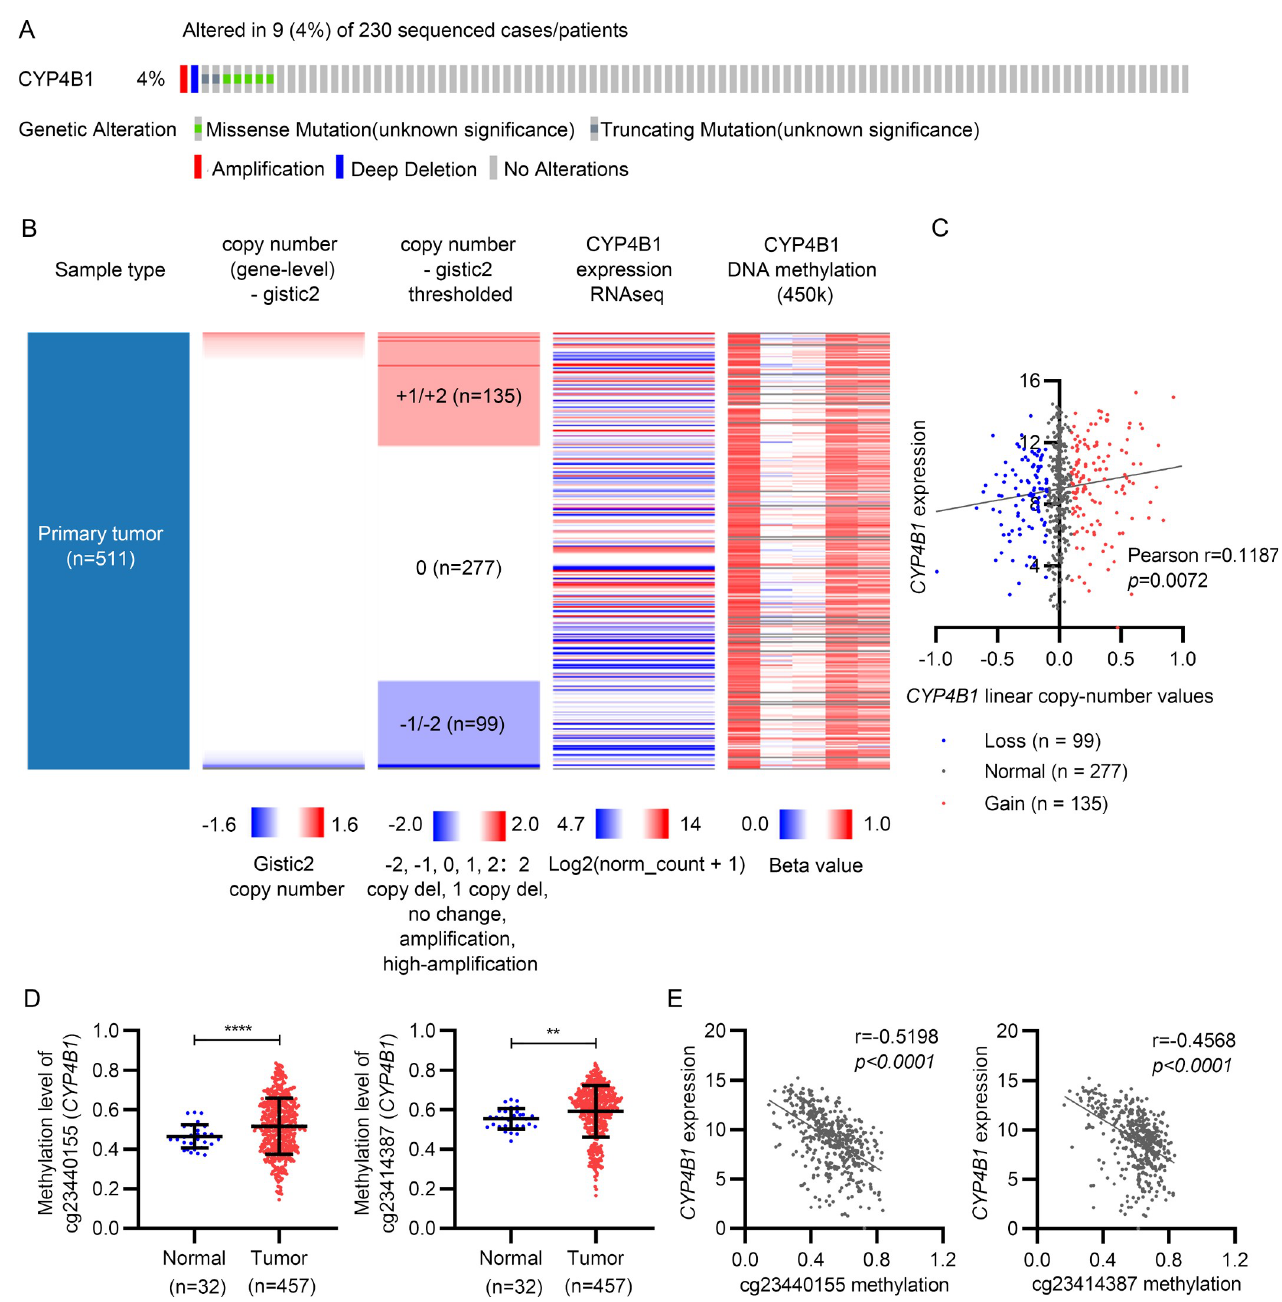
Fig 4. CYP4B1 expression was modulated by its gene alterations and DNA methylation in LUAD. (A) Genetic alterations of CYP4B1 in LUAD. (B) Heatmap of CYP4B1 expression, DNA copy number alterations (gistic2 linear and gistic2 thresholded), and DNA methylation (Methylation 450k). (C) CYP4B1 expression correlates with its linear copy number values by linear regression analysis. (D) DNA methylation level of cg23440155 and cg23414387 sites is significantly upregulated in LUAD tissues when compared with adjacent normal tissues. (E) CYP4B1 expression correlates with cg23440155 and cg23414387 methylation levels by a linear regression analysis. LUAD, lung